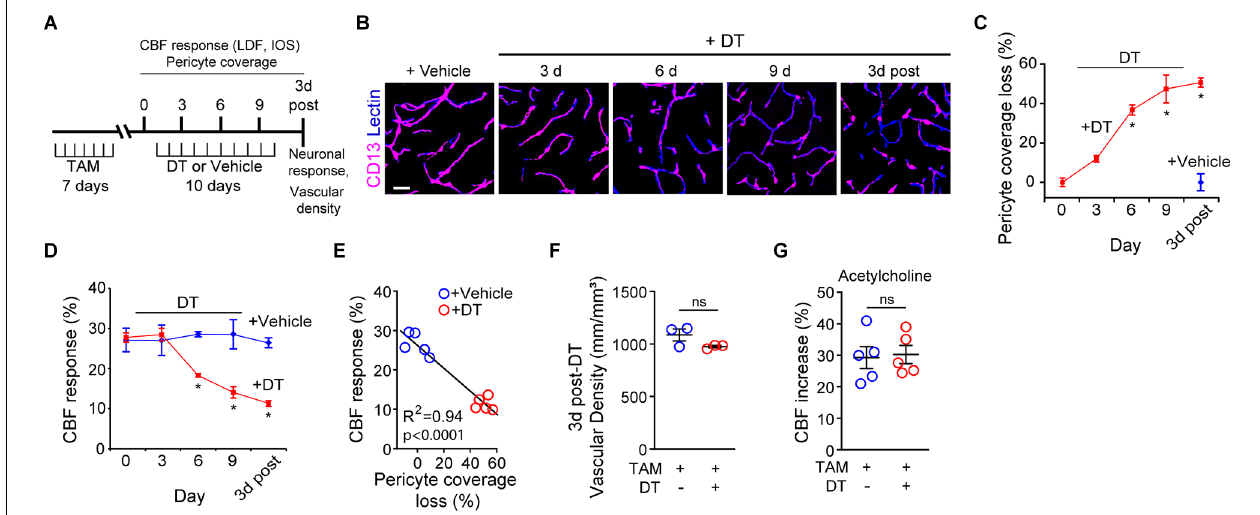
FIGURE 1 | Ablation of cortical pericytes from the adult mouse brain leads to acute dysregulation of neurovascular coupling. (A) A diagram of the injection protocol of pericyte-CreER; iDTR mice with tamoxifen (TAM; 40 mg/kg daily for seven consecutive days), diphtheria toxin (DT; 0.1 mg per day for 10 consecutive days) or vehicle, and the time points when cerebral blood flow (CBF) responses to stimulus measured by laser Doppler flowmetry (LDF) and intrinsic optical signal (IOS) imaging, neuronal response to stimulus, and capillary density measurements were performed. (B) Representative confocal microscopy images of CD13-positive pericyte coverage of lectin-positive endothelial profiles in the S1 cortex hind-limb region at 3, 6, and 9 days of DT or vehicle administration, and 3 days post-DT or vehicle. Bar = 20 µ m. (C) Quantification of pericyte coverage loss on capillaries ( < 6 µ m in diameter) in the S1 cortex in TAM-treated pericyte-CreER; iDTR mice at